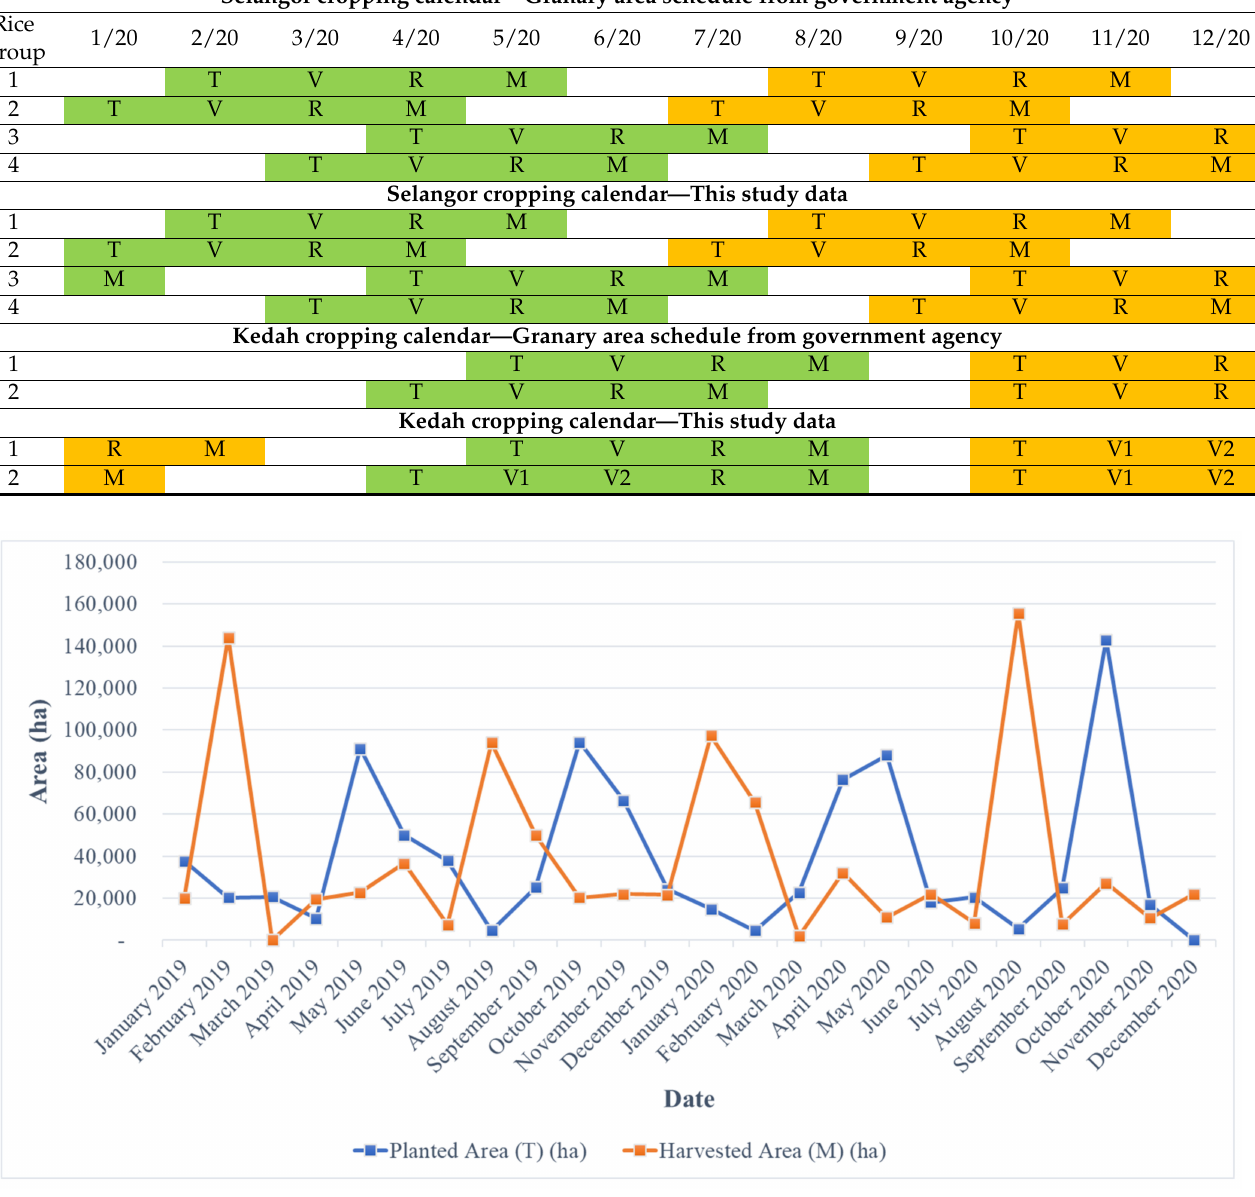
Figure 7. Aggregated planted and harvested rice area in Peninsular Malaysia. Figure 7 corresponds to Table